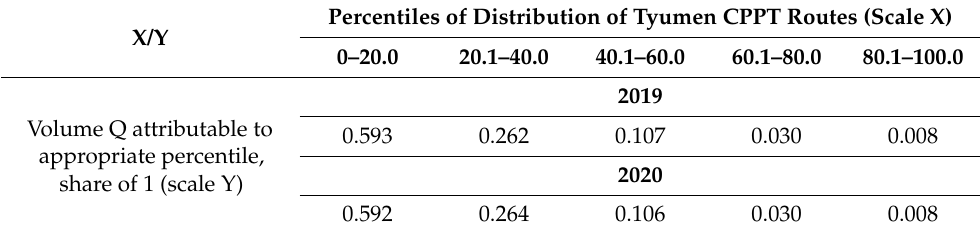
Table 9. Distribution of annual transportations volume Q year by percentiles of Tyumen CPPT routes. X/Y